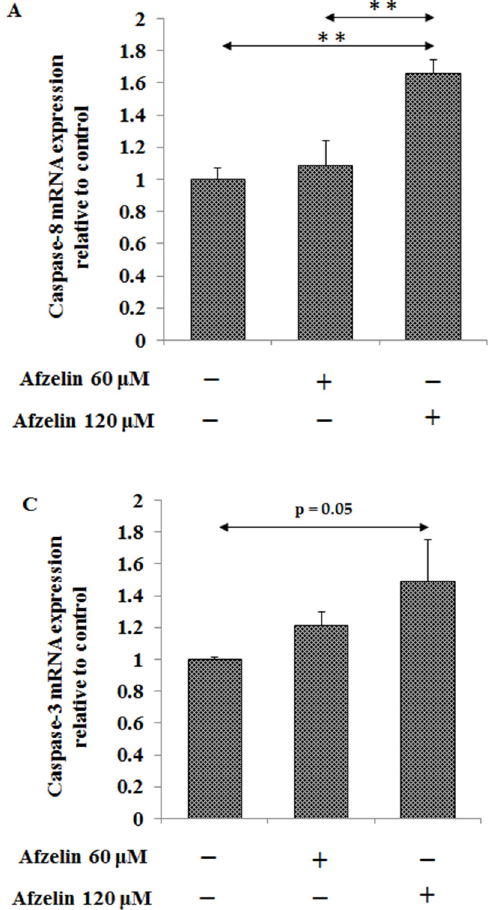
Figure 5. The effect of afzelin on caspase-8 ( A ), caspase-9 ( B ), and caspase-3 ( C ) mRNAs in AGS gastric cancer cells. The cells were incubated for 24 h with 60 and 120 µ M afzelin. mRNA was determined by RT-PCR. The results are presented as a relative fold change in mRNA expression of gene in comparison of gene in control where expression was set as 1. ± SD are the mean of triplicate cultures. ** p < 0.01.